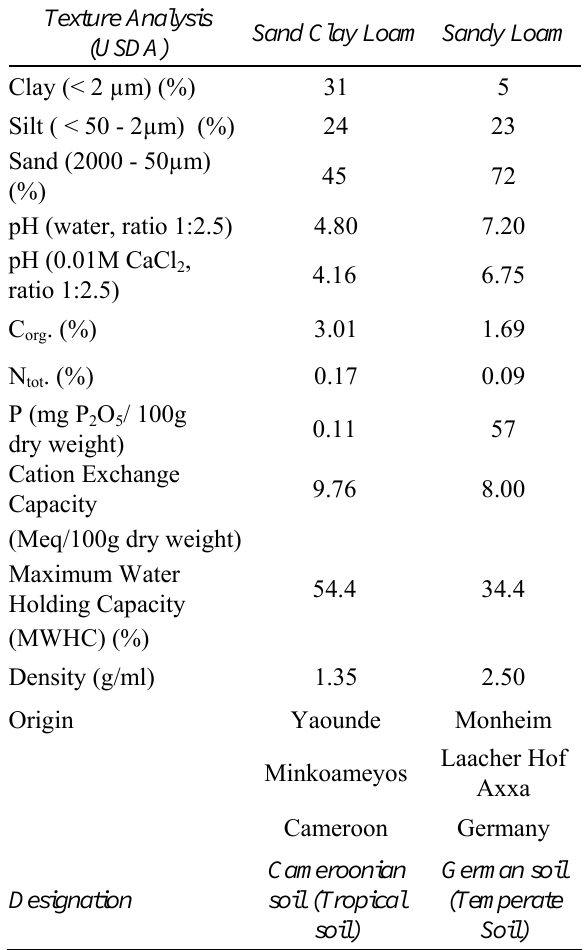
Table 1: Selected physico-chemical properties of